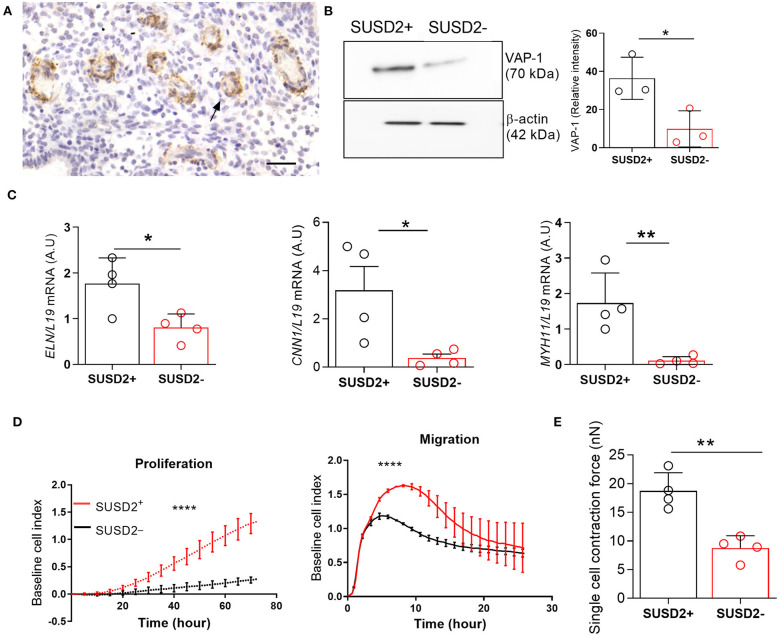
Biophysical and functional characterization of endometrial pericytes and EnSCs. (A) Immunohistochemistry showing VAP-1 expression in luteal-phase human endometrium, hematoxylin was used to stain the nuclei. Staining indicates VAP-1 reactivity in the vasculature and spiral arteries, arrow pointing to spiral artery. Scale bar: 200 μm. (B) VAP-1 expression was determined at protein level in freshly isolated SUSD2+ pericytes and SUSD2− EnSCs from three independent endometrial biopsies by Western blot analysis and normalized to β-actin and relative intensity determined by densitometry; Student's t-test; *P < 0.05. (C) Expression of ELN (left panel), CNN1 (middle panel) and MYH11 (right panel) transcripts was determined by RT-qPCR in freshly isolated SUSD2+ pericytes and SUSD2− EnSCs from four independent endometrial biopsies; Student's t-test; *P < 0.05; **P < 0.01. (D) Representative graphs showing proliferation and migration SUSD2+ pericytes and SUSD2− EnSCs monitored in real-time using the xCELLigence system for the indicated time-points. (E) freshly isolated SUSD2+ pericytes and SUSD2− EnSCs were embedded into collagen at a density of 1 × 106 cells per gel. Single cell contraction force was measured using the depth-sensing nanoindentation system. Data represent mean ± SEM of four biological repeat experiments. Student's t-test; **P < 0.01; ****P < 0.0001.